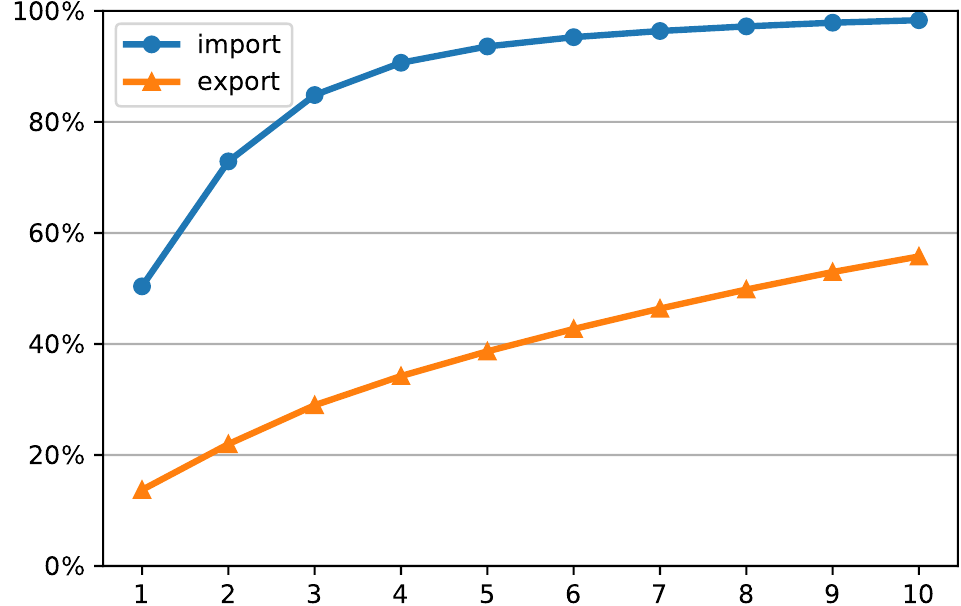
Figure 8. The relationship between the percentage of EGSR s in the Top-level network to the overall EGSR s of the Belt and Road economies and the level selected by the Top network.